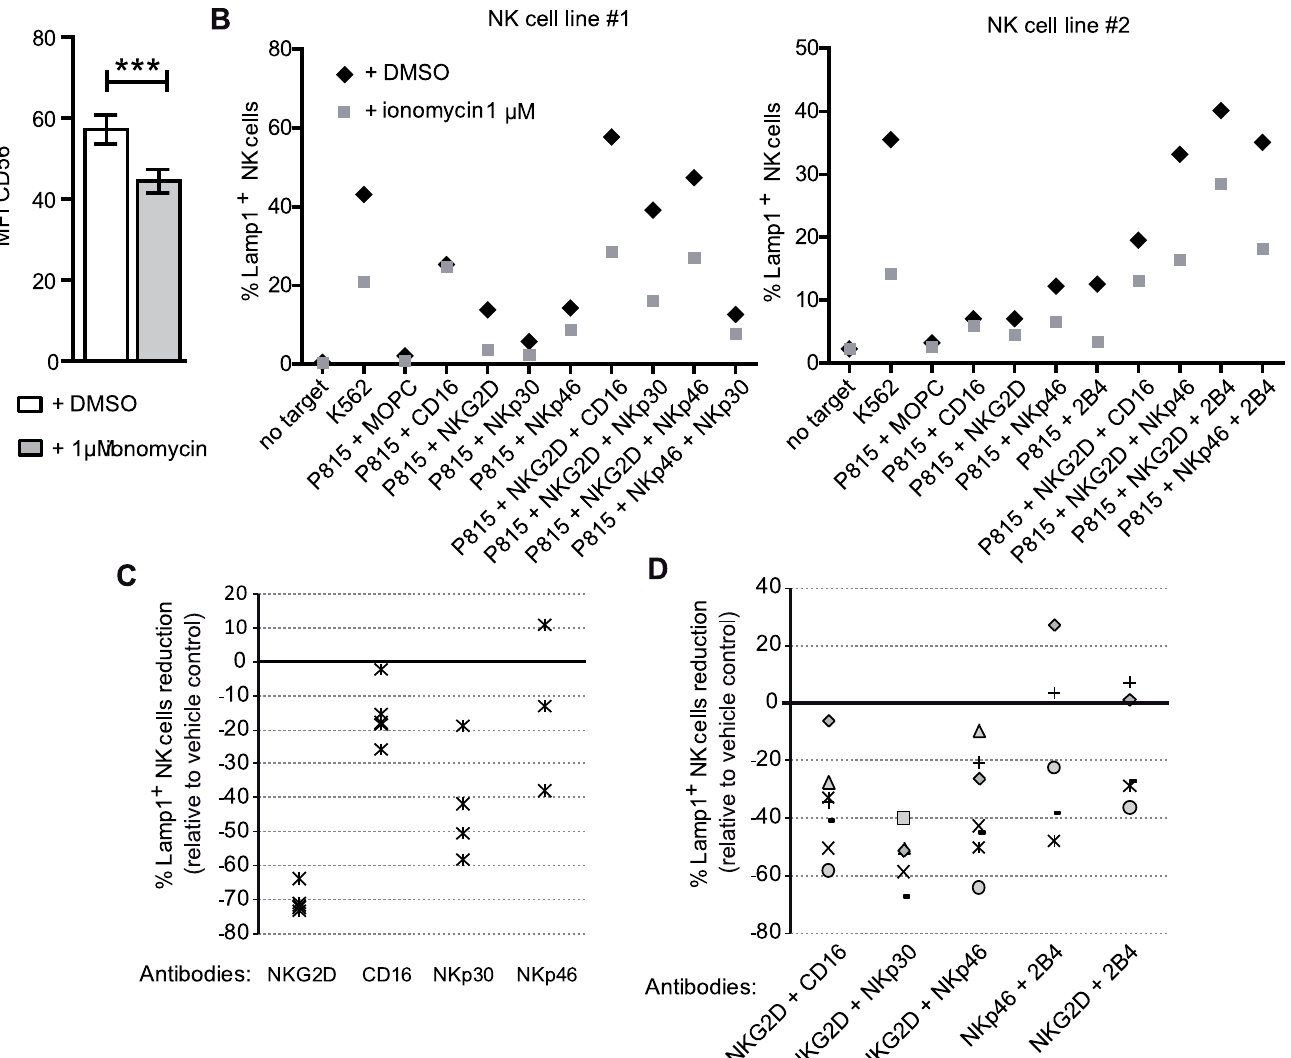
Fig 5. Ionomycin treatment reduces NK cell receptor function. ( A ) Ionomycin treatment reduces the expression of CD56 on NK cells. ( B ) NK cells were cocultured with P815 cells loaded with 10 μ g/mL of the indicated antibodies alone or in combinations. Representative examples of data from two donors. ( C ) Relative numbers of NK cells able to degranulate in response to P815 cells and the indicated antibodies (each symbol corresponds to a different experiment), or ( D ) combinations of antibodies(each symbol corresponds to a different experiment).